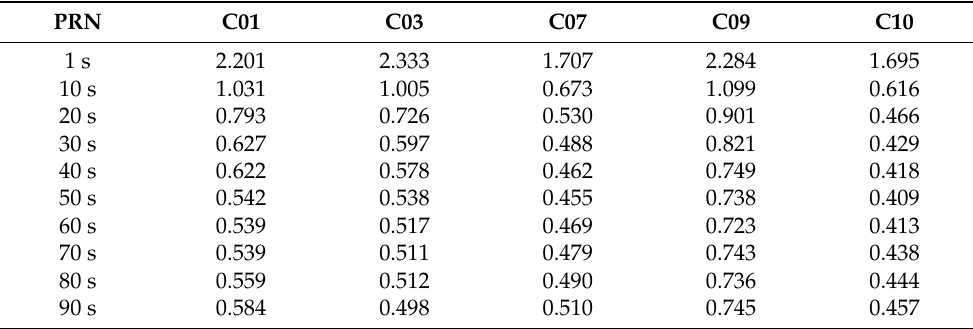
Table 2. APSD of the zenith ionospheric delays calculated with different differential interval of the long-range baseline. The sampling rate is 1 Hz and the unit is mm/